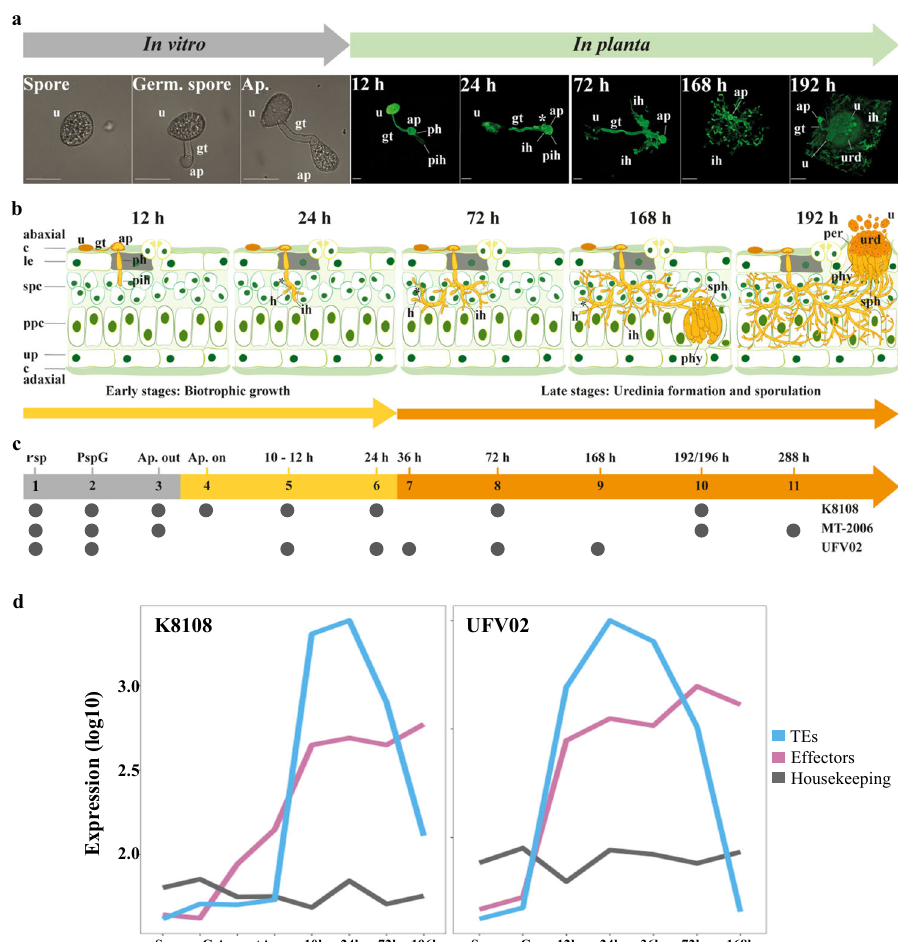
Fig. 3 | Infection cycle of P. pachyrhizi and gene expression on the critical infection stages. a Developmental phases of P. pachyrhizi infection in vitro and in planta on susceptible soybean plants. Scale bar, 10 μ m for the in vitro germinated assays micrograph, 20 μ m for the 12h − 72h in planta micrograph, and 50 μ m for 168hand192h inplanta micrograph.Representativemicrographsareshownfrom three independently performed assays with similar results. b Schematic of critical infectionstagesshowninthepanel(a). c RNAsequencingonthecriticaltime-points from three isolates. The timepoints included in this study are indicated by grey circles for each isolate. d Average expression (log10 of CPM) of the 246 core